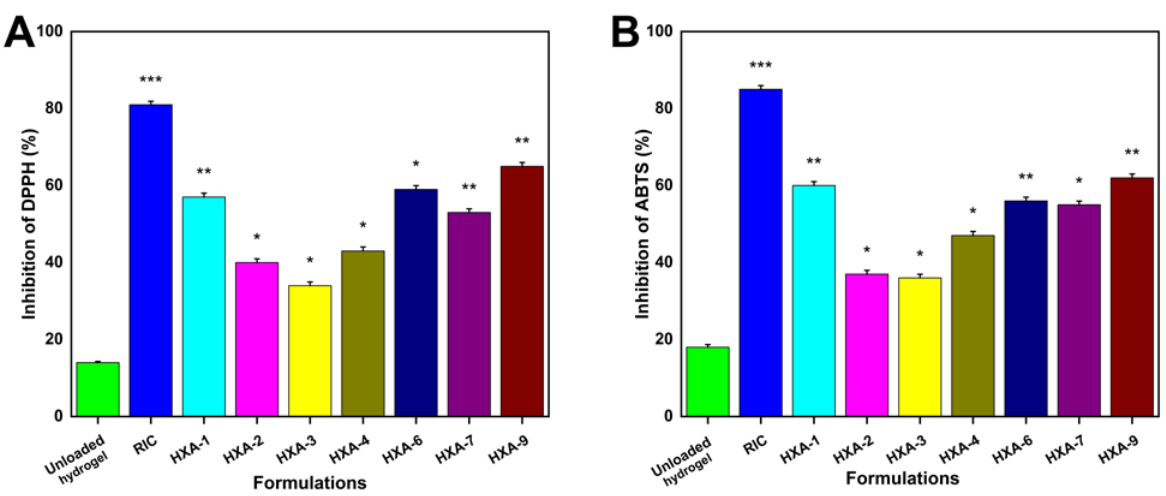
Figure 11. Hydrogel antioxidant activity was assessed using the DPPH ( A ) and the ABTS assay ( B ). (Here, * shows the p value < 0.05, ** p < 0.01, and *** p < 0.001).